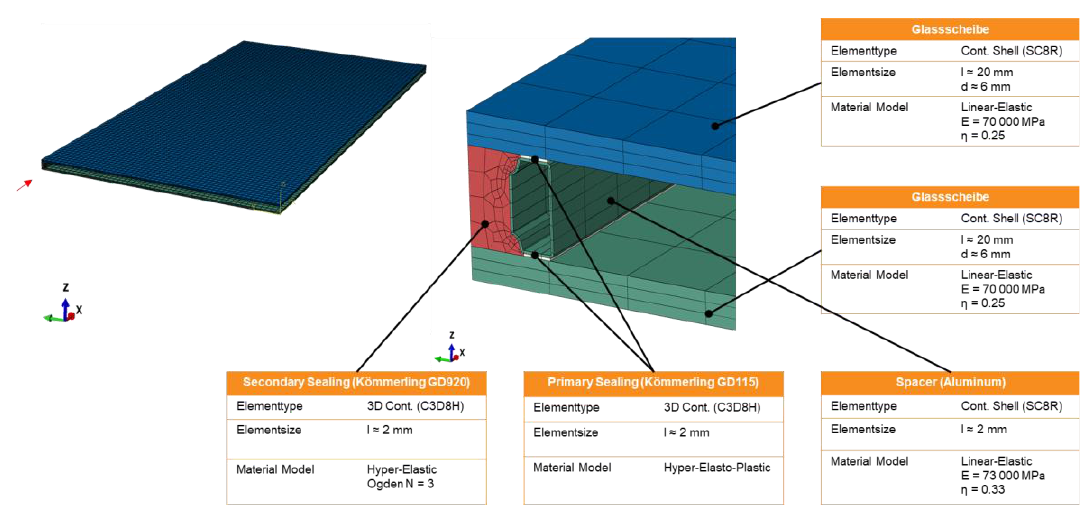
Fig. 8 FE model of the insulating glass unit with aluminum (box)